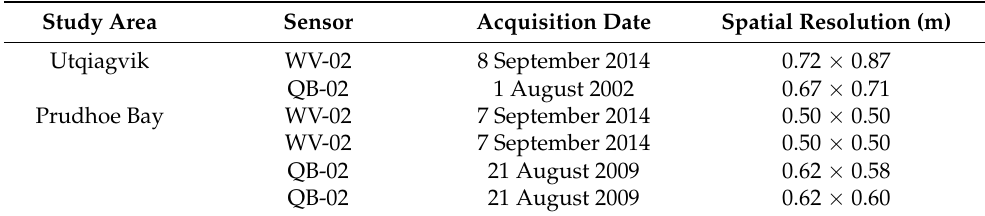
Table 2. General characteristics of VHSR commercial satellite image scenes used to train and test the U-Net CNN.